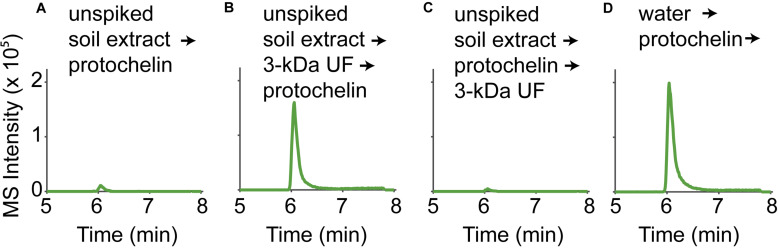
LC-MS signals of a protochelin standard (3.1 μM) in (A) an unspiked soil extract; (B) an unspiked soil extract that was 3-kDa ultrafiltered before protochelin addition; (C) an unspiked soil extract that was 3-kDa ultrafiltered after protochelin addition; (D) water.